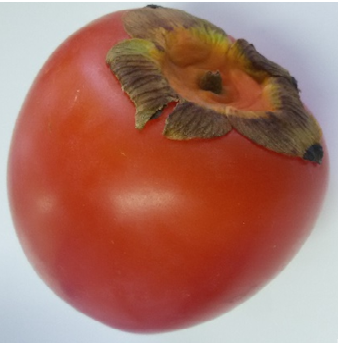
Figure 1. Persimmon, Diospyros kaki L. fruit from Algarve,